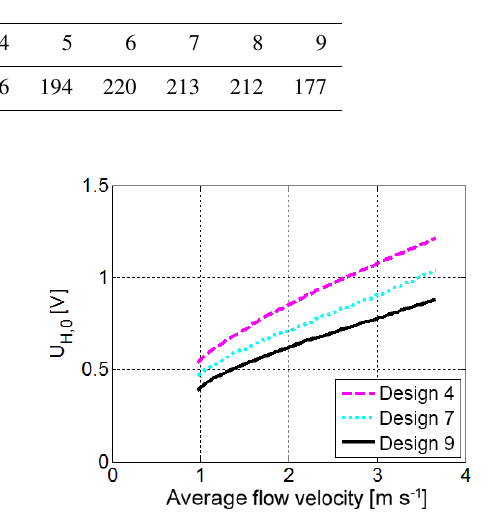
Table 2. Mean sensitivity of the investigated designs in the range from 1 to 3.6 ms − 1 .